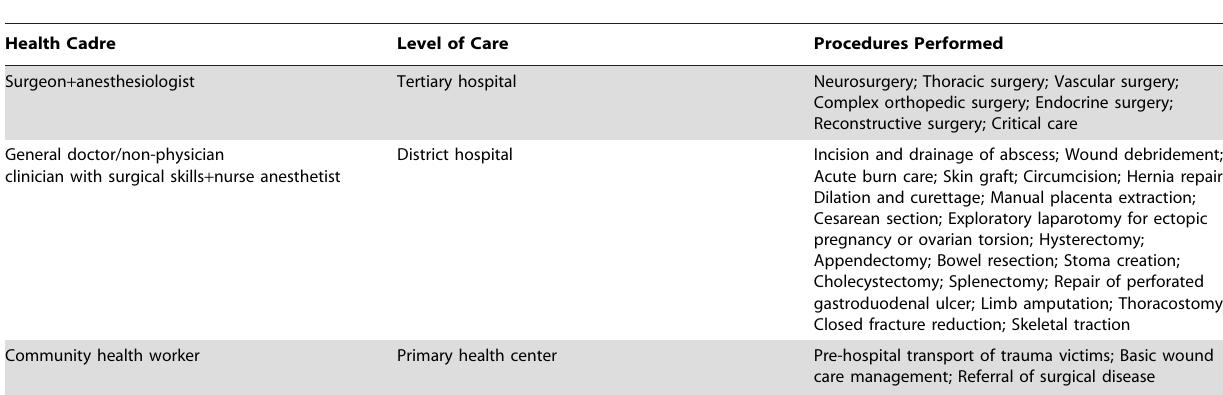
Table 1. Examples of surgical tasks that could be performed by different health workers.